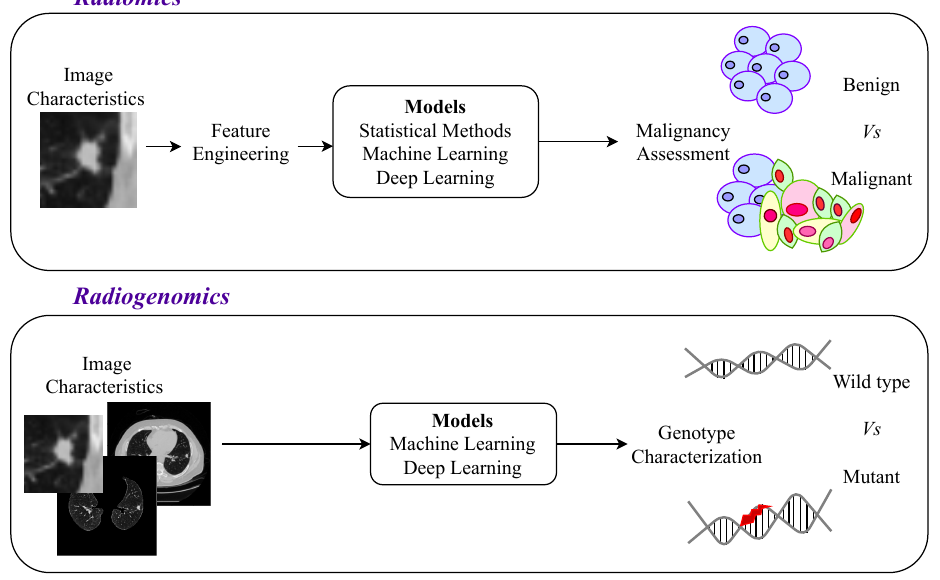
Figure 3. Radiomic vs. radiogenomic perspectives for lung cancer assessment. The assessment of lung cancer was first based on the nodule; however, recently, in radiogenomics approaches, other lung structures were shown to have relevant information for cancer characterization. Those approaches brought new challenges, such as the segmentation of lungs, to use this region of interest (ROI) in the AI-based